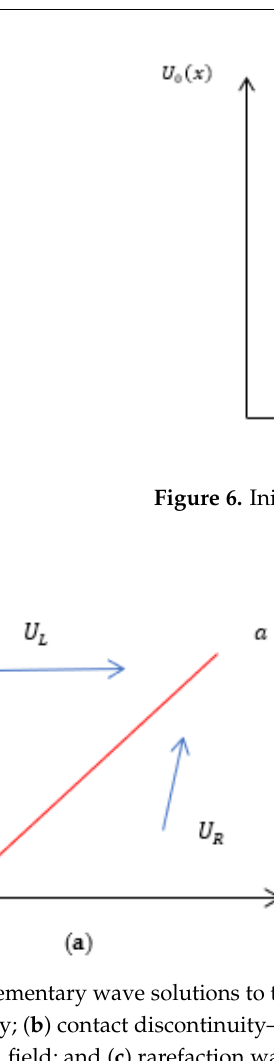
Figure 5. Solution of the Riemann problem in the physical space (top) and in the phase space (bottom) [9].